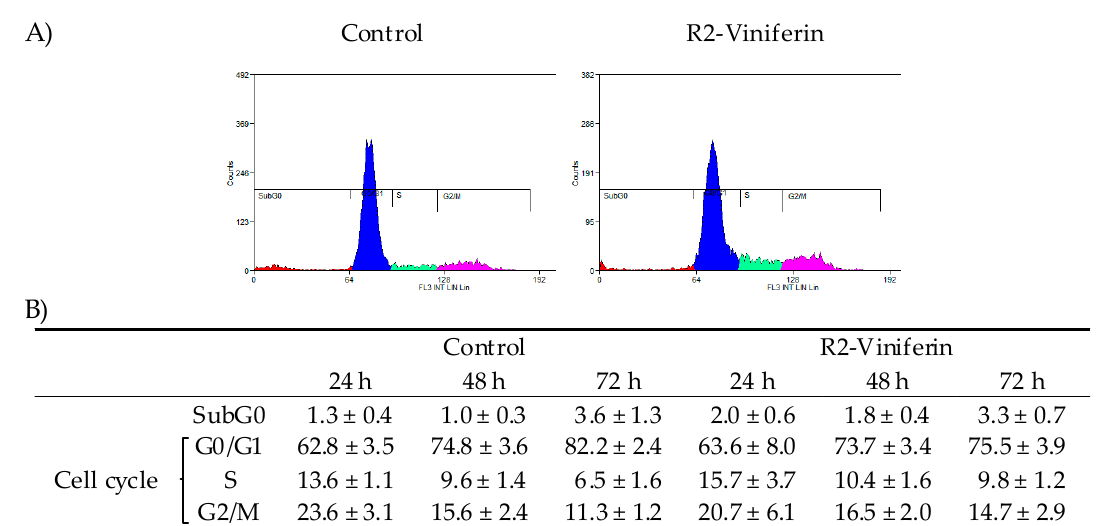
Figure 3. Cell cycle distribution of HepG2 treated with R2-viniferin. (A ) Representative graphs of cell cycle analysis by flow cytometry at 72 h. ( B ) Statistical analysis of cell cycle distribution. Data are expressed as the percentage (%) of cells at different stages of cell cycle. In the case of cells in subG0, data are expressed as the percentage of total cells. Results are the mean ± SE of three experiments. * p <0.001, significantly different from control.